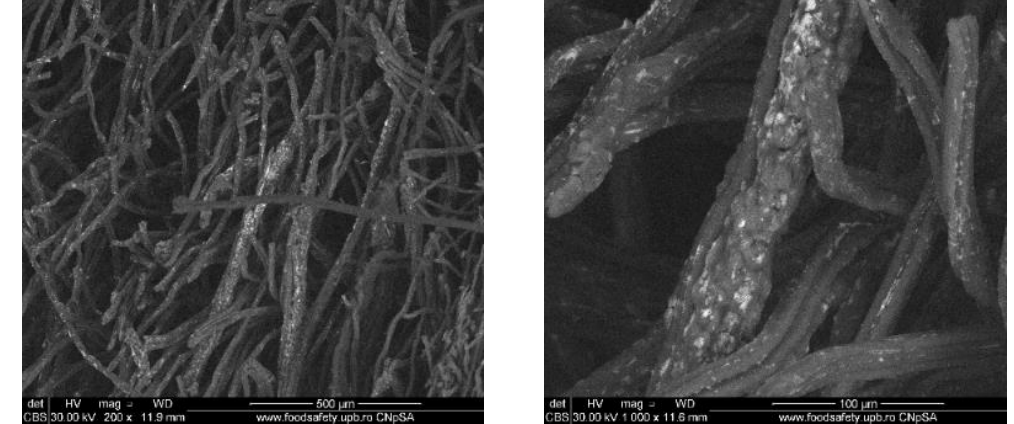
Figure 7. SEM images of wound dressings with silver nanoparticles, sodium alginate and cloves oil. Left: global image, and right: detailed image.